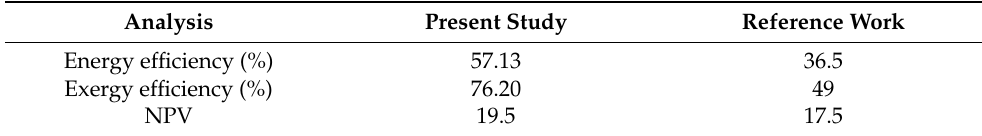
Table 7. Results comparison of the present study and reference